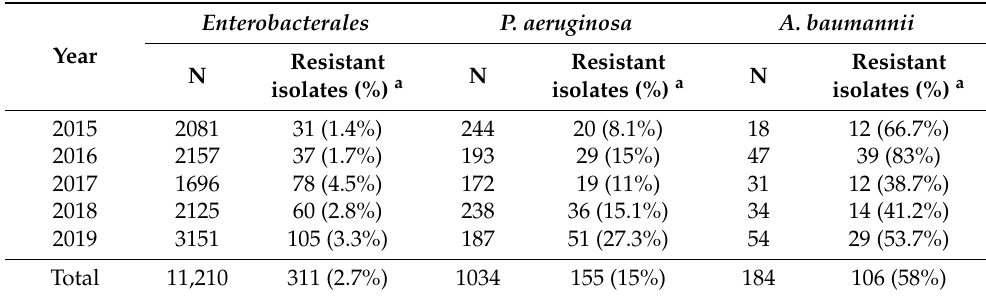
Table 1. Prevalence of carbapenem resistance in Enterobacterales , P. aeruginosa and A. baumannii , from 2015 to 2019, isolated in northern Lebanon, selected based on their resistance to ertapenem according to EUCAST guidelines [10].